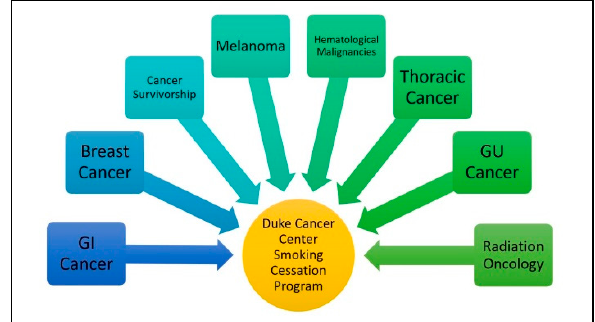
Figure 2. Traditional referral to the Duke Cancer Center Smoking Cessation Program.